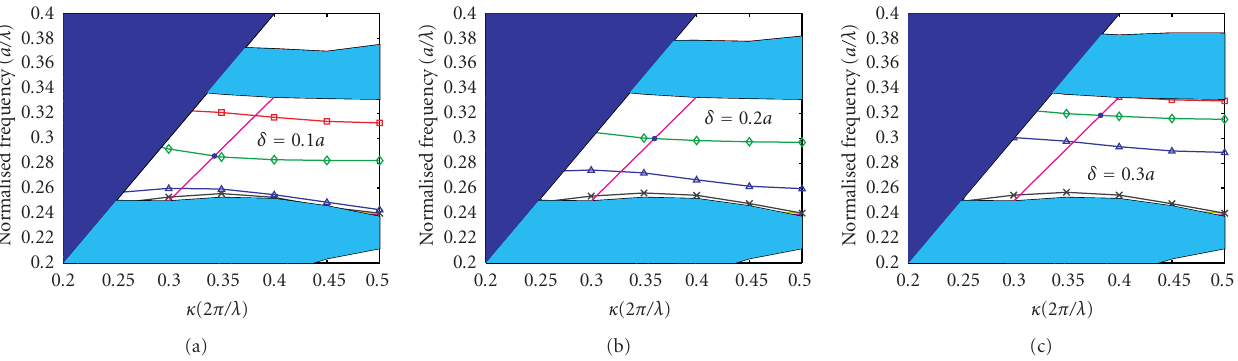
Figure 4: Band diagrams for modified PCSW. (a) PCSW 1 with δ = 0.1 a ; (b) PCSW 2 with δ = 0.2 a ; (c) PCSW 3 with δ = 0.3 a . Note that higher-order modes (blue curve with triangle marker and black curve with cross marker) are pulled up from the lower band edge.